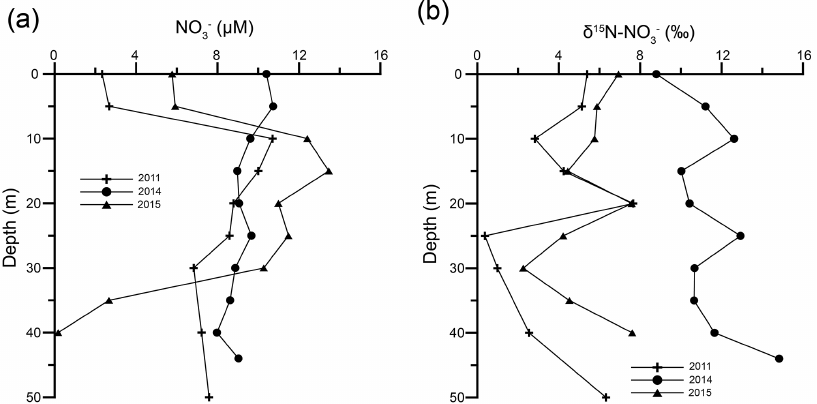
Figure 7. Vertical profiles of NO − (a) and δ 15 N–NO − (b) during monsoon mixing in 2011, 2014 and 2015. Each profile is from one field 3 3 trip during the peak SWM in a given year with each data point representing one